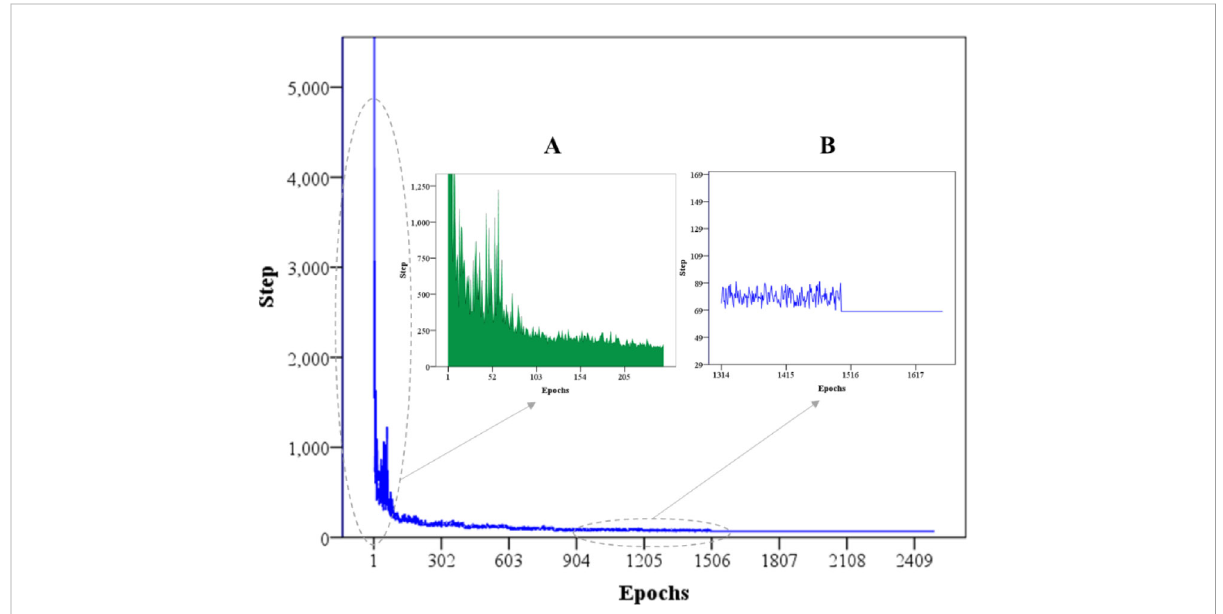
FIGURE 9 Training step variation with each epoch from the start point to the goal in simulation scenario 2, including And enlarged (A) 1-205 epochs and (B) 1314-1617 epochs two parts.